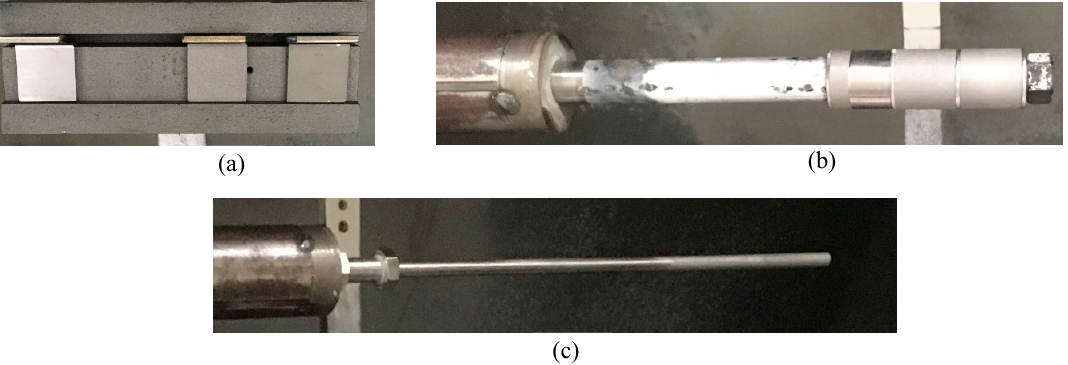
Figure 7. Fixtures with samples: ( a ) flat; ( b ) cylindrical; and ( c ) rod.